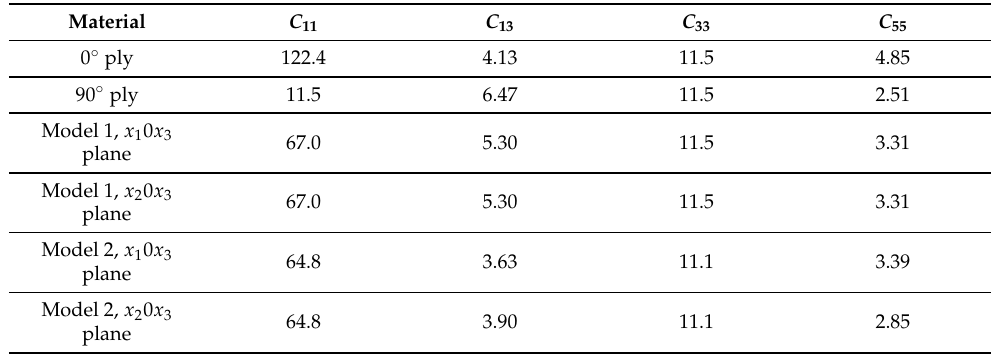
Table 2. Elastic constants of anisotropic waveguides [GPa].